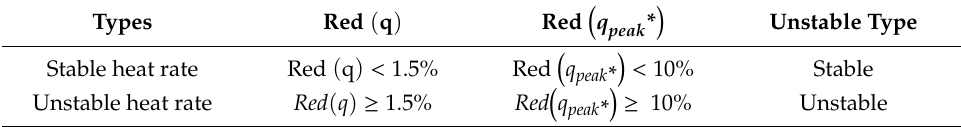
Table 1. A threshold to estimate a thermal response test (TRT) with an unstable power input [23].